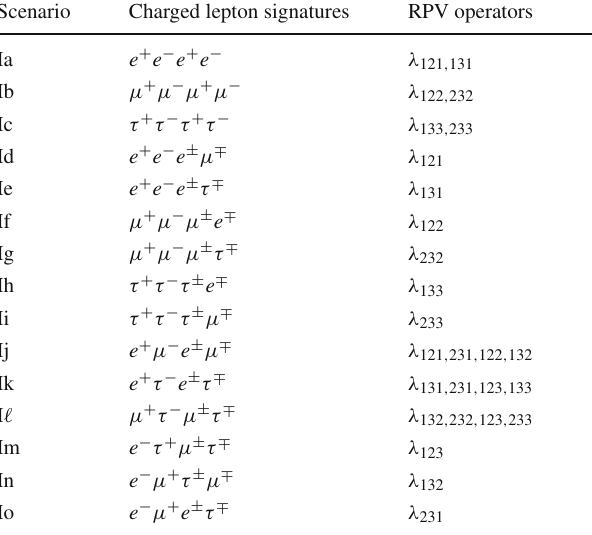
Table 3 Possible charged lepton final states in the LL ¯ E case for a pair of LSP neutralinos resulting from the cascade decays of pair/associated producedSUSYparticles.Ineachcase,ifdistinct,thechargedconjugate final state is also possible. The various charge combinations have equal branching ratios, due to the Majorana nature of the ˜ χ 0 states are accompanied by (at least) two neutrinos typically leading to some missing transverse momentum